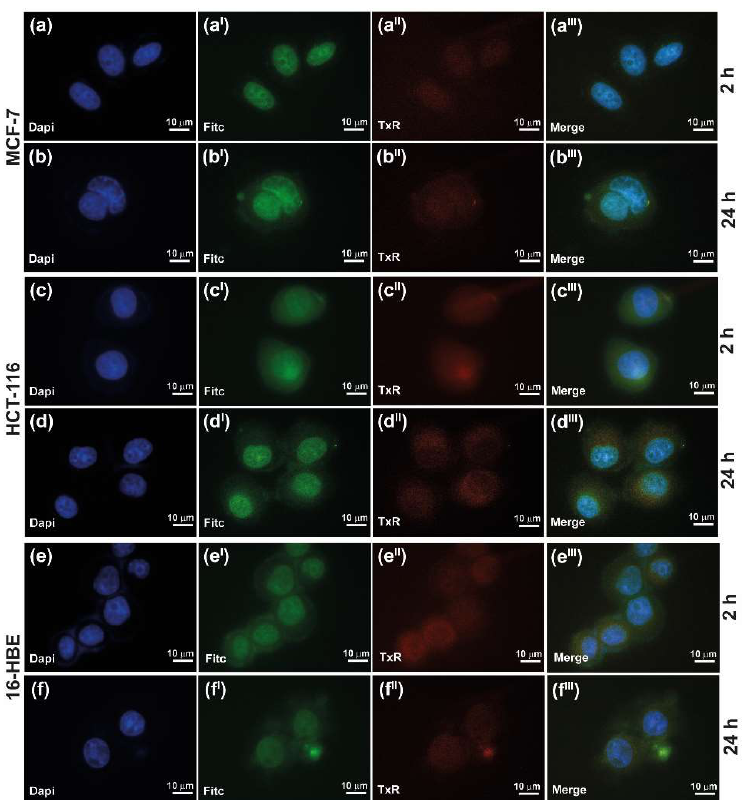
Figure 7. Cell uptake of loaded INU-Cys-TC@SN38 on MCF-7 ( a–a III , b–b III ), HCT-116 ( c–c III , d–d III ) and 16-HBE ( e–e III , f–f III ) after 2 h and 24 h of incubation. Lysosomes were stained with TxR (red), nuclei with DAPI (blue), and SN38 is self-stained